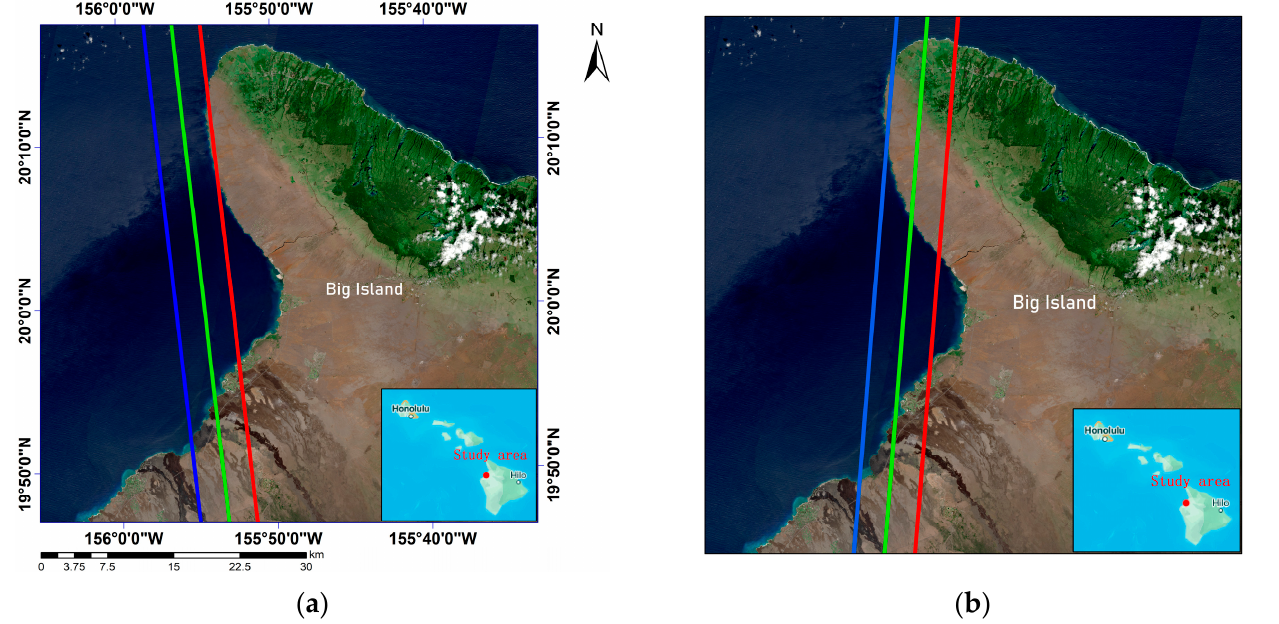
Figure 1. ( a ) Photon tracks of 1036 orbit: the blue, green, and red lines are the photon tracks of the gt3r, gt2r, and gt1r beams; ( b ) photon tracks of 480 orbit: the blue, green, and red lines are the photon tracks of the gt1r, gt2r, and gt3r beams.